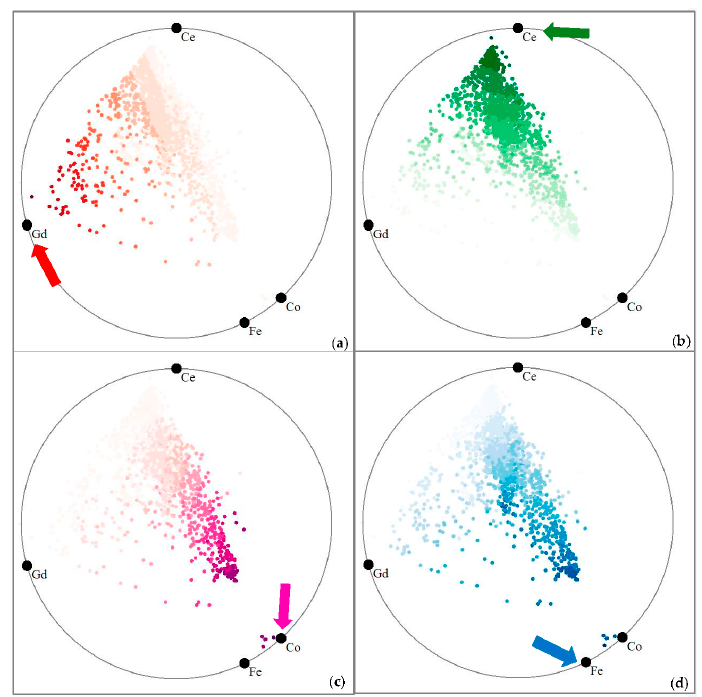
Figure 8. The sample values in terms of “Gd” ( a ); “Ce” ( b ); “Co” ( c ) and “Fe” ( d ) respectively. The darker intensities correspond to higher values.